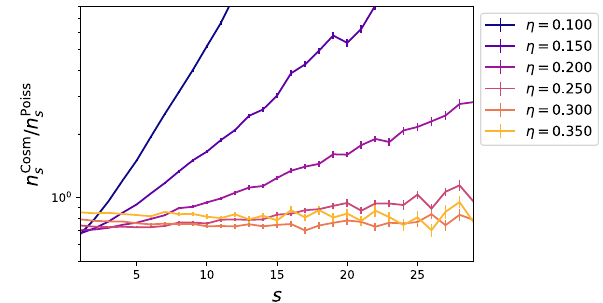
FIG. 9. Comparison of the cluster size distribution in the cosmological and Poisson simulations. We plot the mean number of s -mers per unit particle (defined as clusters containing s member) as a function of s , normalizing to the Poisson prediction. Results are shown for various values of the reduced density η and we assume an aperiodic simulation volume of size L ¼ 800 h − 1 Mpc, averaging over 100 realizations. At large η , the two sets of simulations have a similar n distribution (at least for s small s ), while at low η , the enhanced clustering in the cosmo- logical simulations leads to significantly more s -mers, with the mean number of particles per cluster increasing with η (cf. Fig.